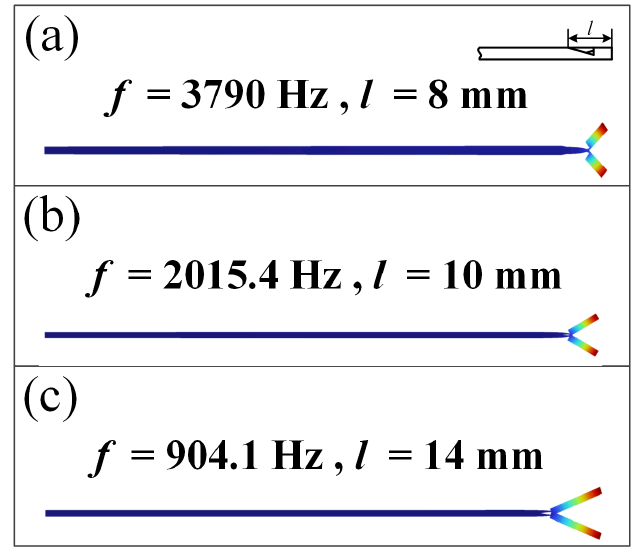
Figure 8. Mode shape simulations with arbitrary lengths of end-efforts: (a) l = 8 mm (b) l = 10 mm (c) l = 14 mm.